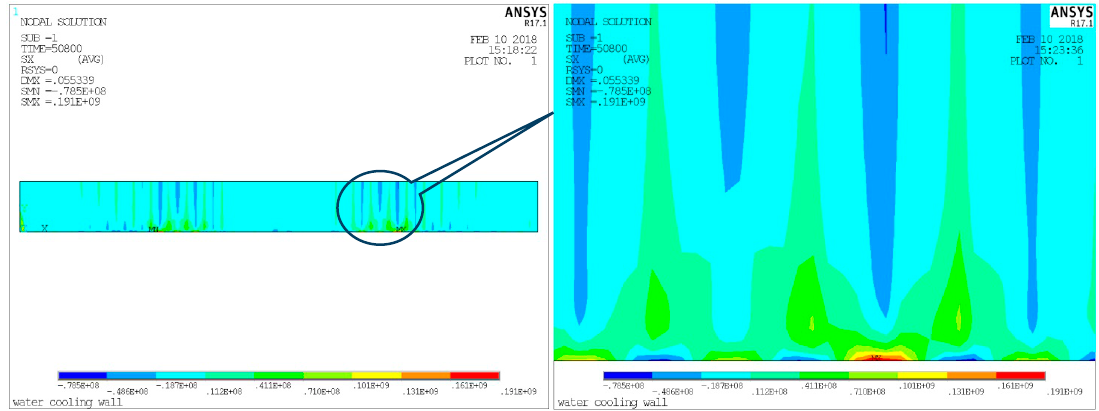
Figure 14. Thermal stress contour of the X direction at the highest tube temperature difference. Energies 2019 , 12 , x